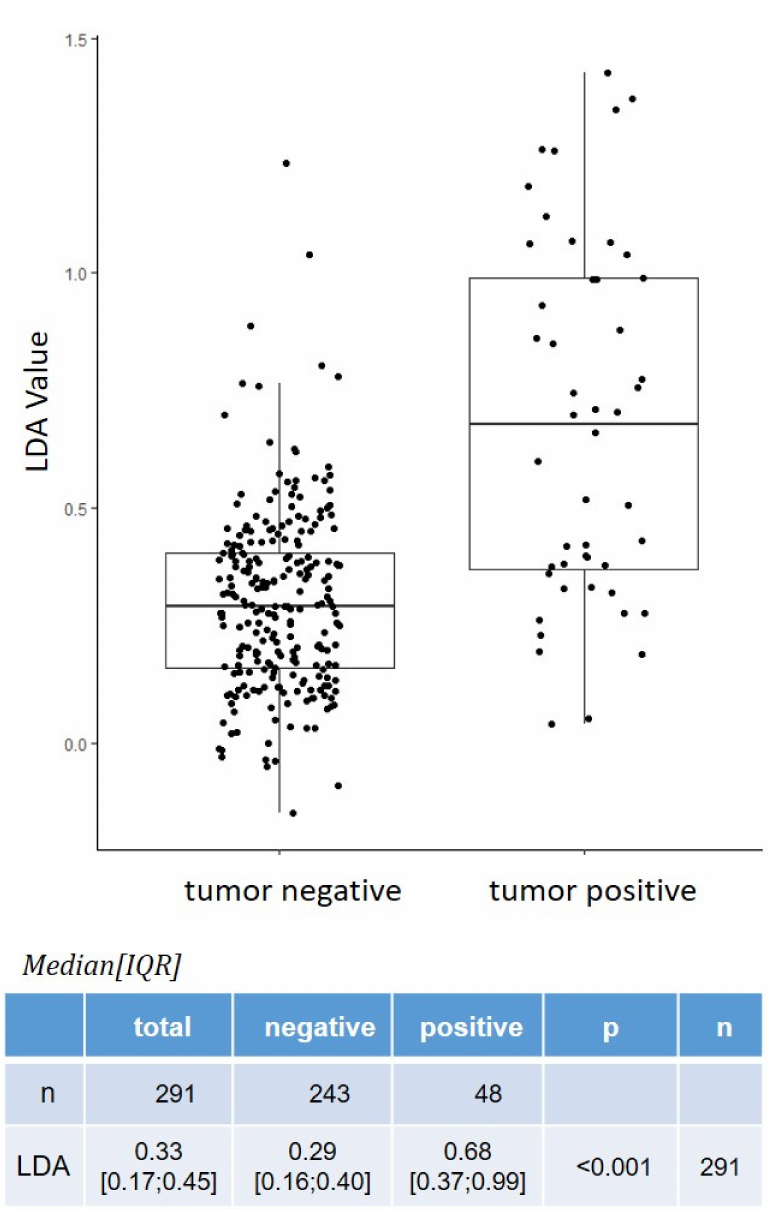
Figure 1. Boxplot of XBCM LDA values for tumor negative and tumor positive